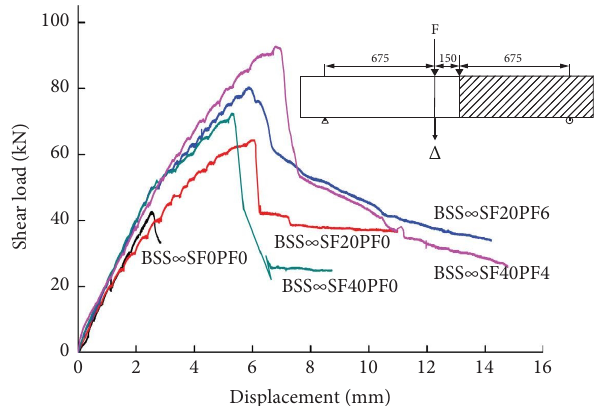
Figure 5: Shear load-displacement curves of the beams with dif- ferent fber types and without